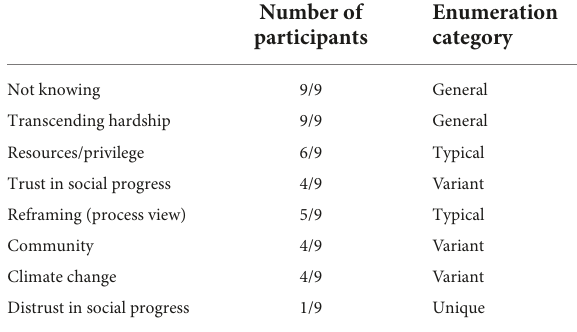
TABLE 1 Enumeration of